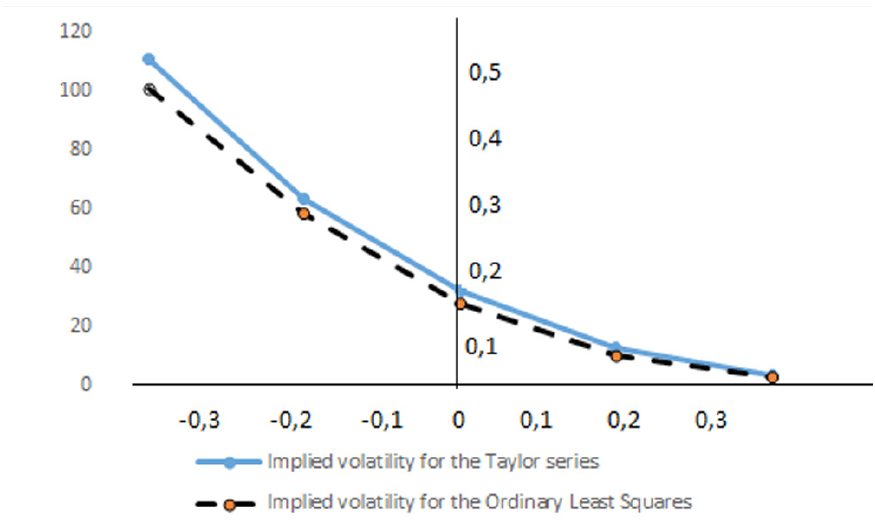
Figure 1. The implied volatility obtained by the Ordinary Least Squares and our second order approximation by the Taylor series for the degenerate Heston model